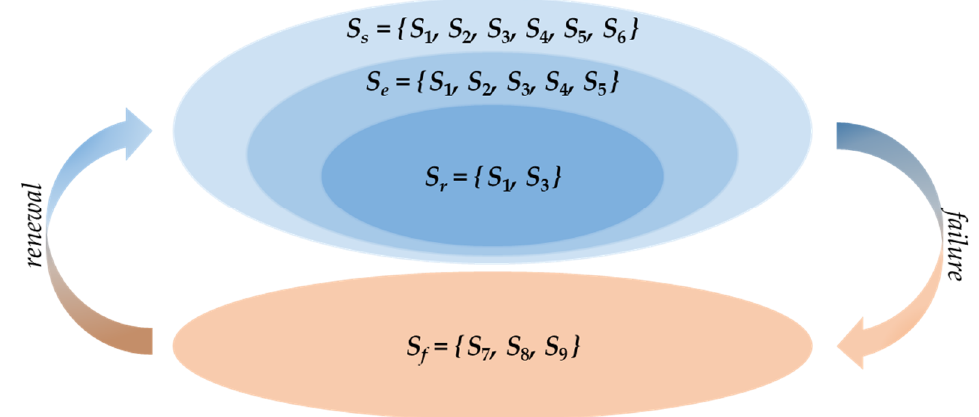
Figure 6. Subsets of light utility vehicle exploitation states.